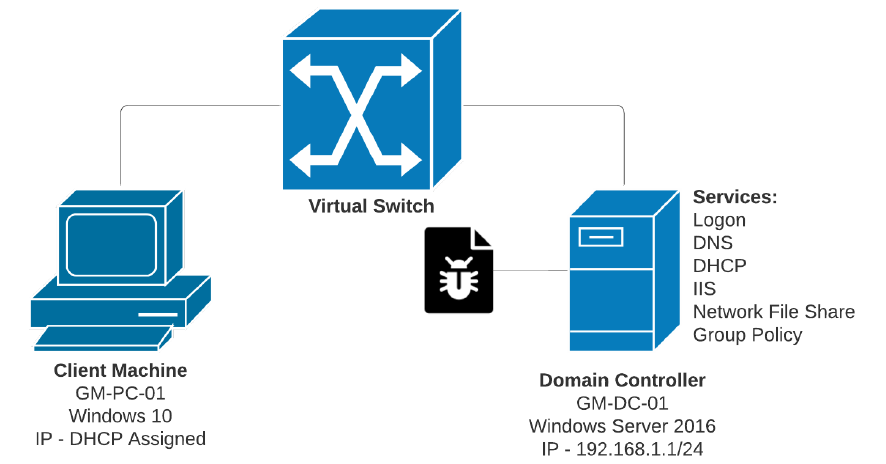
Figure 2. Diagram of virtual network